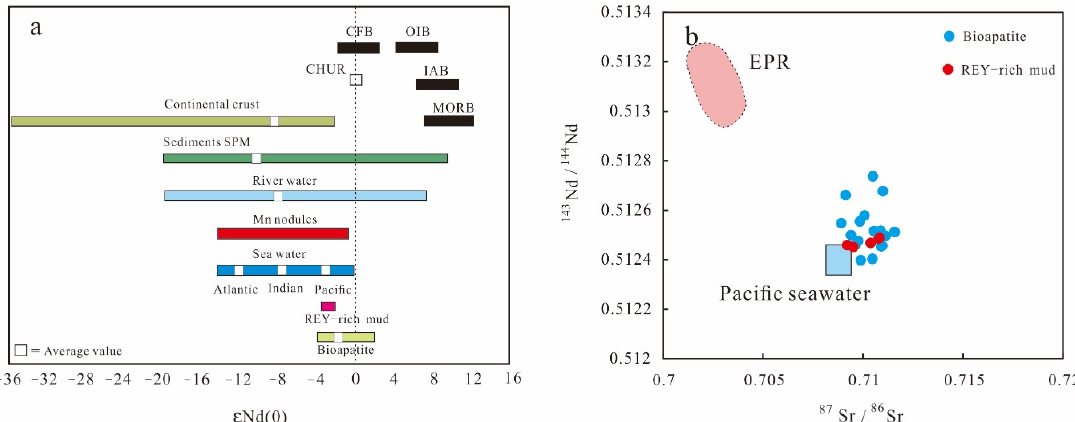
Figure 10. ( a ) Comparison of ε Nd(0) values in the REY-rich muds and bioapatites with various sources. ( b ) Plot of ( 87 Sr/ 86 Sr) vs ( 143 Nd/ 144 Nd) for the REY-rich muds and bioapatites. Natural variability of the Nd isotope composition in different rocks, sediments, and waters, given ε Nd(0) values relative to CHUR, modified after [59]. Mid-oceanic ridge basalts proposed by [60]. River water and river sediment ε Nd(0) values after [61,62]; seawater ε Nd(0)values for the different ocean basins after [63] and [64]. CHUR = chondritic uniform reservoir; CFB = continental flood basalt; OIB = ocean island basalt; IAB = island arc basalt; MORB = mid-oceanic ridge basalt. EPR/Chile Ridge field proposed by [65].